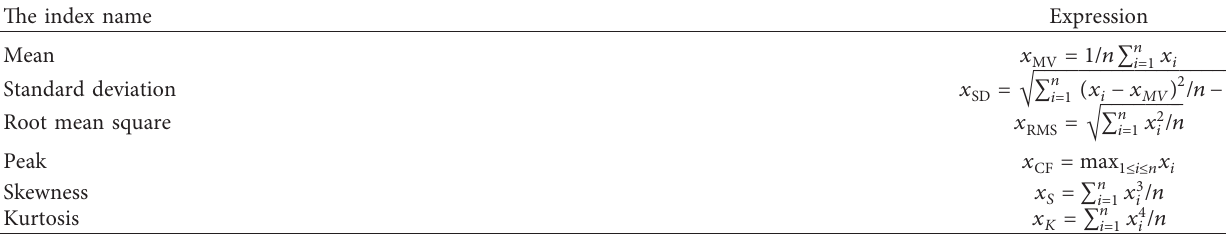
Table 2: List of time domain features.